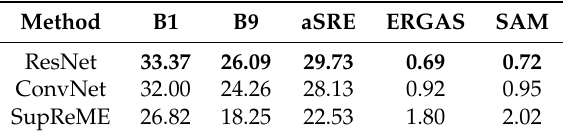
Table 2. Quantitative evaluation results for 360 m to 60 m super-resolution. The data have been degraded six-fold in resolution in order to use the observed 60 m bands as the reference image. Columns B1 and B9 are the band-wise SRE values, while aSRE is the average SRE of the bands and is given in dB. SAM is given in degrees. Bold typeface indicates the best results.